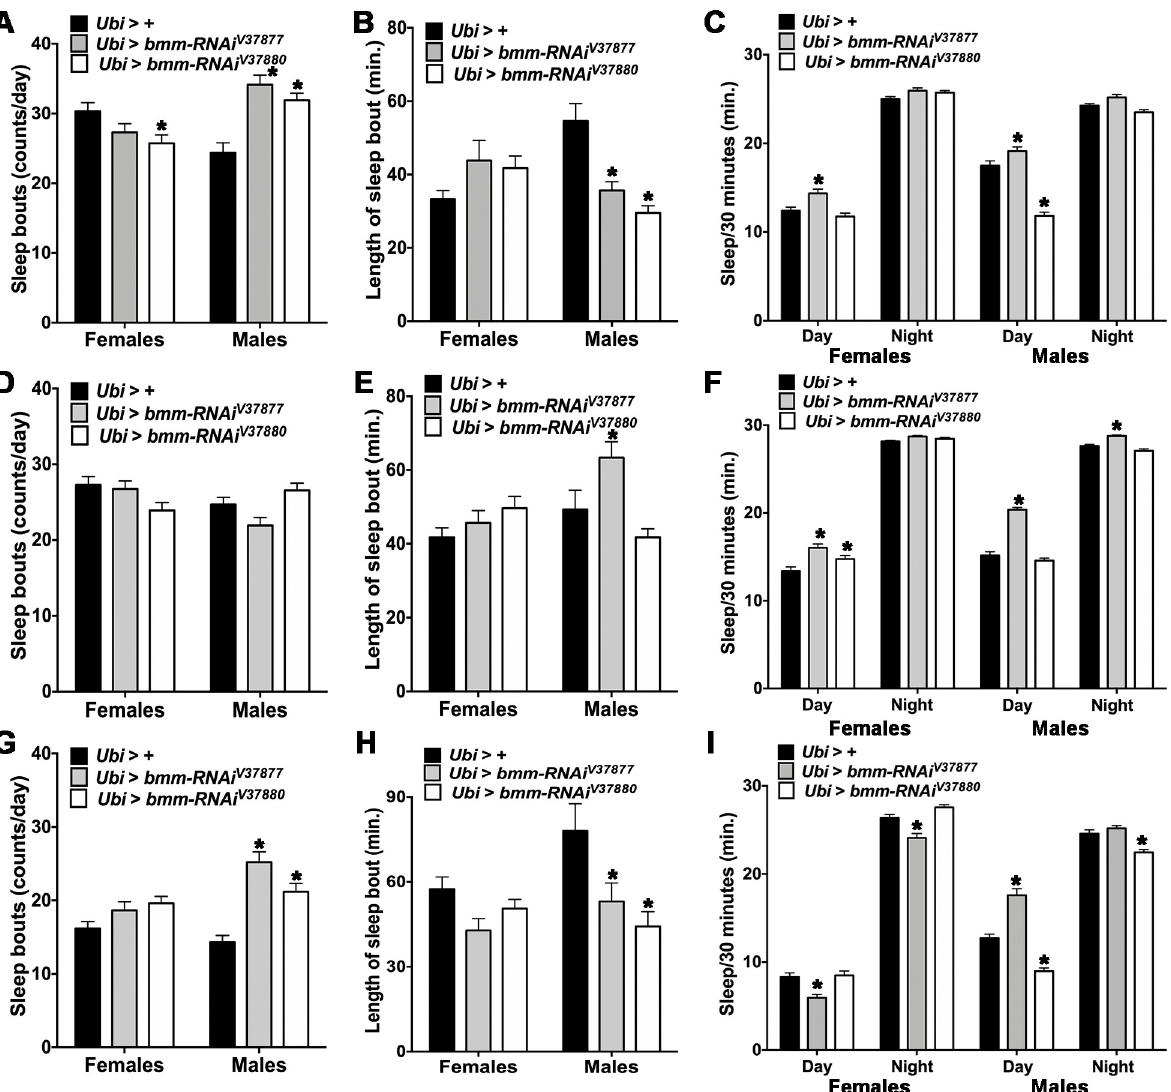
Fig 3. Sleep behavior in Ubi > bmm-RNAi flies. Offspring of Ubi-Gal4 mated with GD control ( Ubi > +) or UAS-bmm-RNAi flies ( Ubi > bmm- RNAi V37877 and Ubi > bmm-RNAi V37880 ) were used for the sleep assay in normal feeding (a-c), normal feeding without wings (d-f) and starvation conditions (g-i). (a, d and g) Average number of sleep bouts. (b, e and h) Average length of sleep bout. (c, f and i) Average sleep during the daytime and the nighttime. Sleep was calculated using the standard definition of a continuous period of inactivity lasting at least 5 minutes, and average was calculated from 7 days of behavior assay except for starvation, which was measured over 3 days, and recalculated to periods of 30 minutes of sleep. Asterisks indicate significant differences at p < 0.05 compared with the appropriate female or male control, following Tukey’s correction for multiple tests. Error bars are SEM. ANOVA tests are reported in S3 Table.